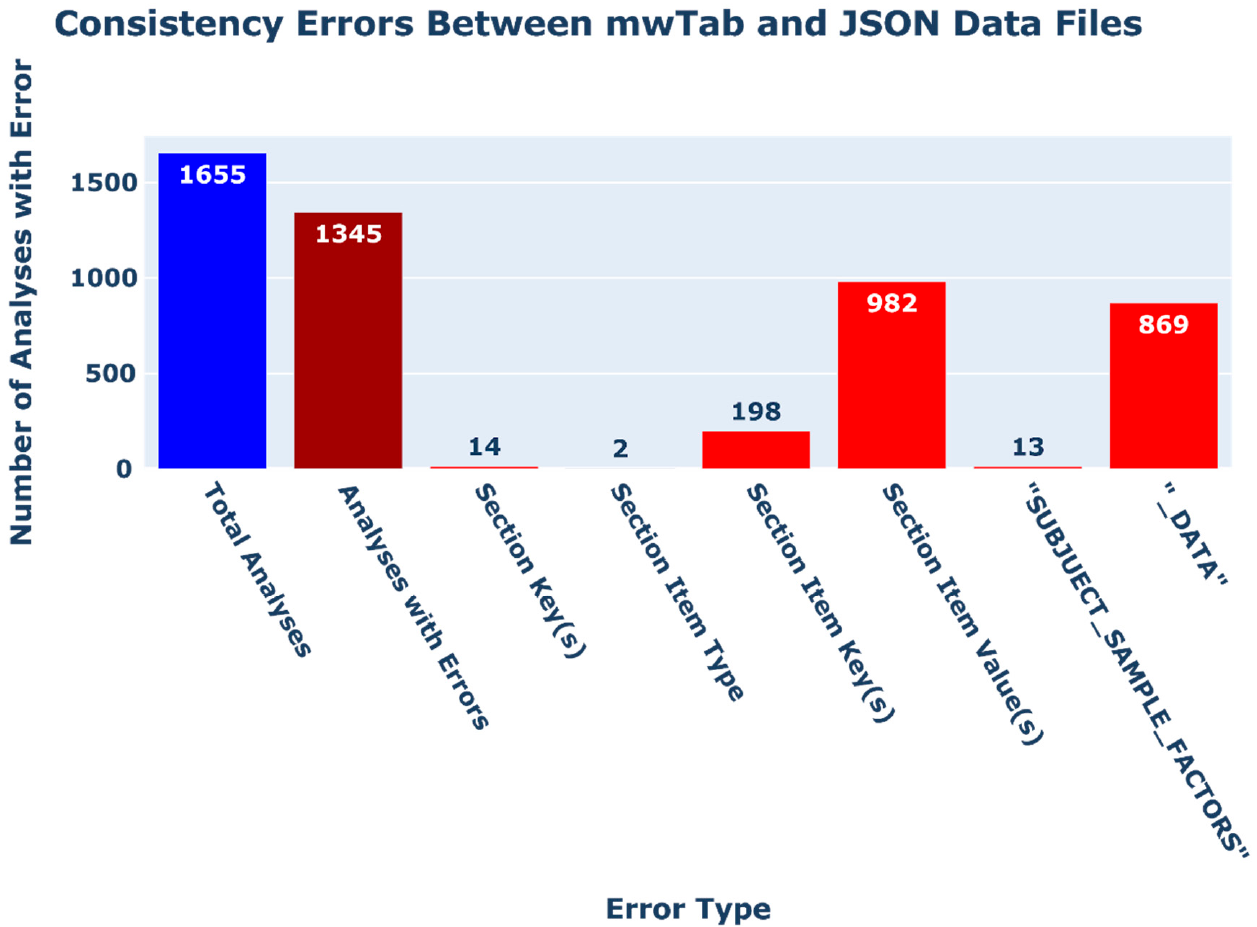
Figure 1. Bar chart depicting the count of consistency errors between ‘mwTab’ and JSON formatted data files. The total number of analyses for which both ‘mwTab’ and JSON formatted files were available upon download and could be parsed into ‘~mwtab.mwtab.MWTabFile’ objects is shown in blue on the left. The total number analyses with inconsistencies between the two available data file formats is shown in dark red second from the left. The remaining red bars show the number of analyses which possess each given inconsistency type.